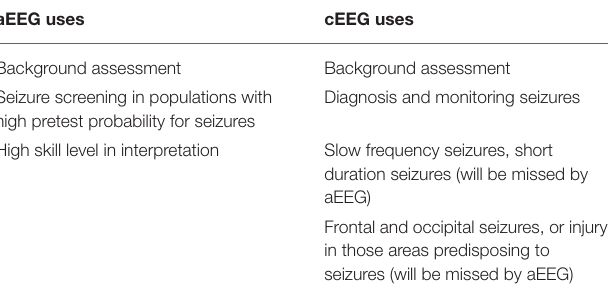
TABLE 4 | Future directions for continuous